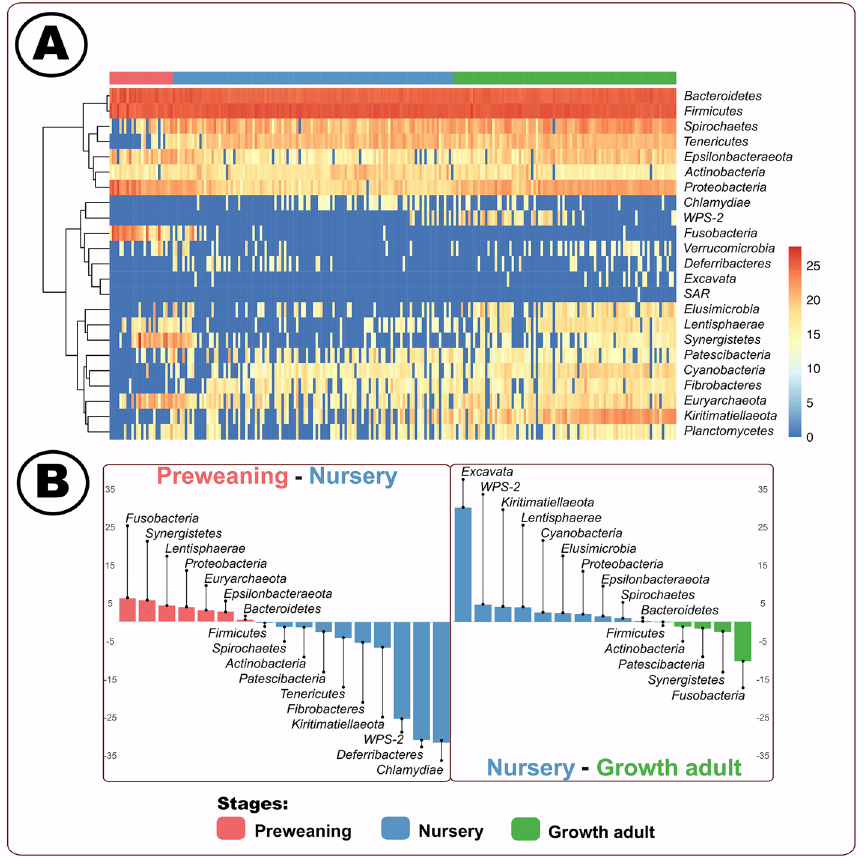
Figure 2. ( A ) Longitudinal heat map of DESeq2 resulting phyla relative abundances; each column represents a distinct sample 33,35,36 . ( B ) DESeq2 differentially identified (p < 0.05) phyla 33,35 . Figure was edited in Inkscape version 1.0.2 (https:// inksc ape. org/) 88